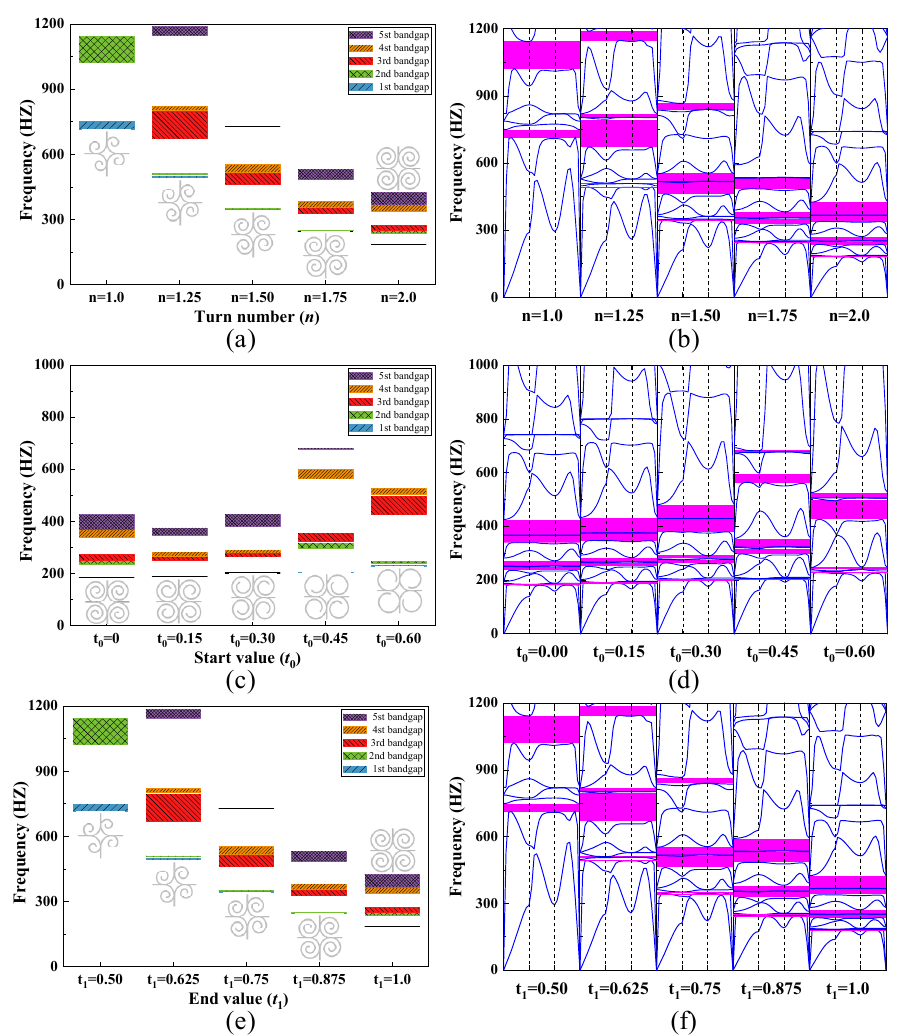
Figure 14. The dependence of the bandgap width on ( a , b ) the turn number n , ( c , d ) the start value t 0 , and ( e , f ) the end value t 1 .